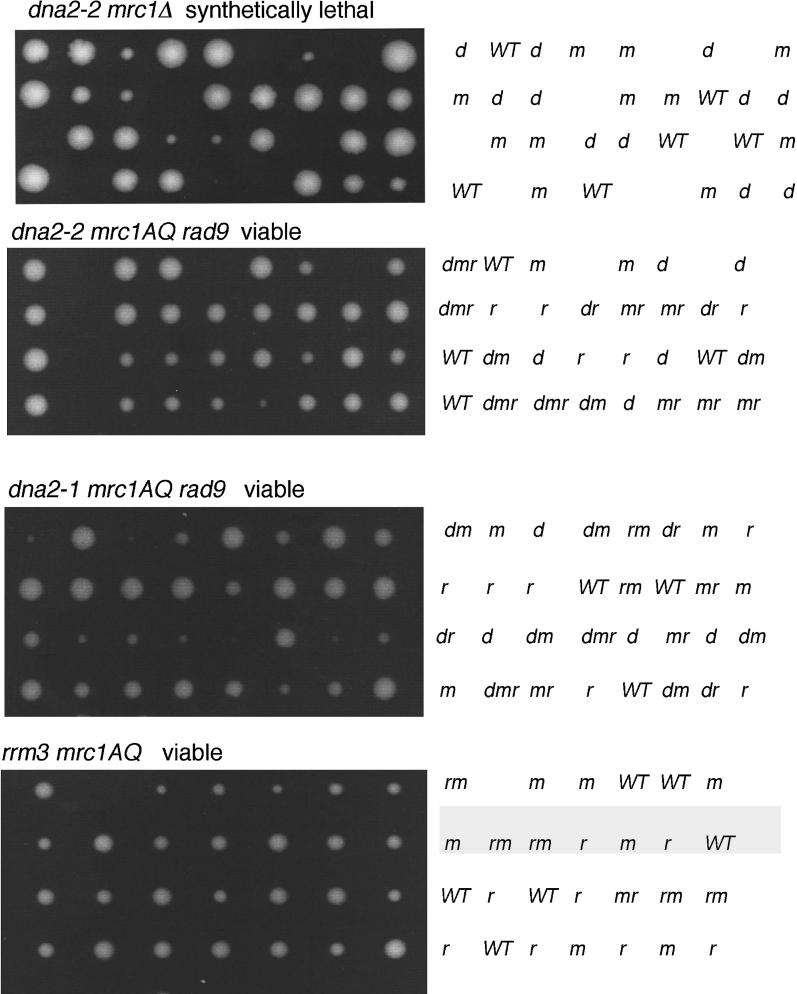
Separation-of-Function Checkpoint Mutants mrc1AQ and rad9Δ Are Not Synthetically Lethal with dna2 or rrm3Δ Mutants
mrc1Δ experiments were carried out in the isogenic 4741 strain and are listed in Table S4. mrc1AQ experiments were carried out in strains isogenic with W303 RAD5
+.Panel 1 (top): segregants from a DNA2/dna2–2 MRC1/mrc1Δ diploid. Segregants are isogenic with 4741. d, dna2–2; m, mrc1Δ.
Panel 2: segregants from a MRC1/mrc1AQ RAD9/rad9Δ DNA2/dna2–2 diploid. d,
dna2–2; m, mrc1AQ; r, rad9Δ.Panel 3: segregants from a DNA2/dna2–1 MRC1/mrc1AQ RAD9/rad9Δ strain. d, dna2–1; m, mrc1AQ; r, rad9Δ.Panel 4 (bottom): segregants from a RRM3/rrm3Δ MRC1/mrc1AQ diploid. m, mrc1AQ; r, rrm3.